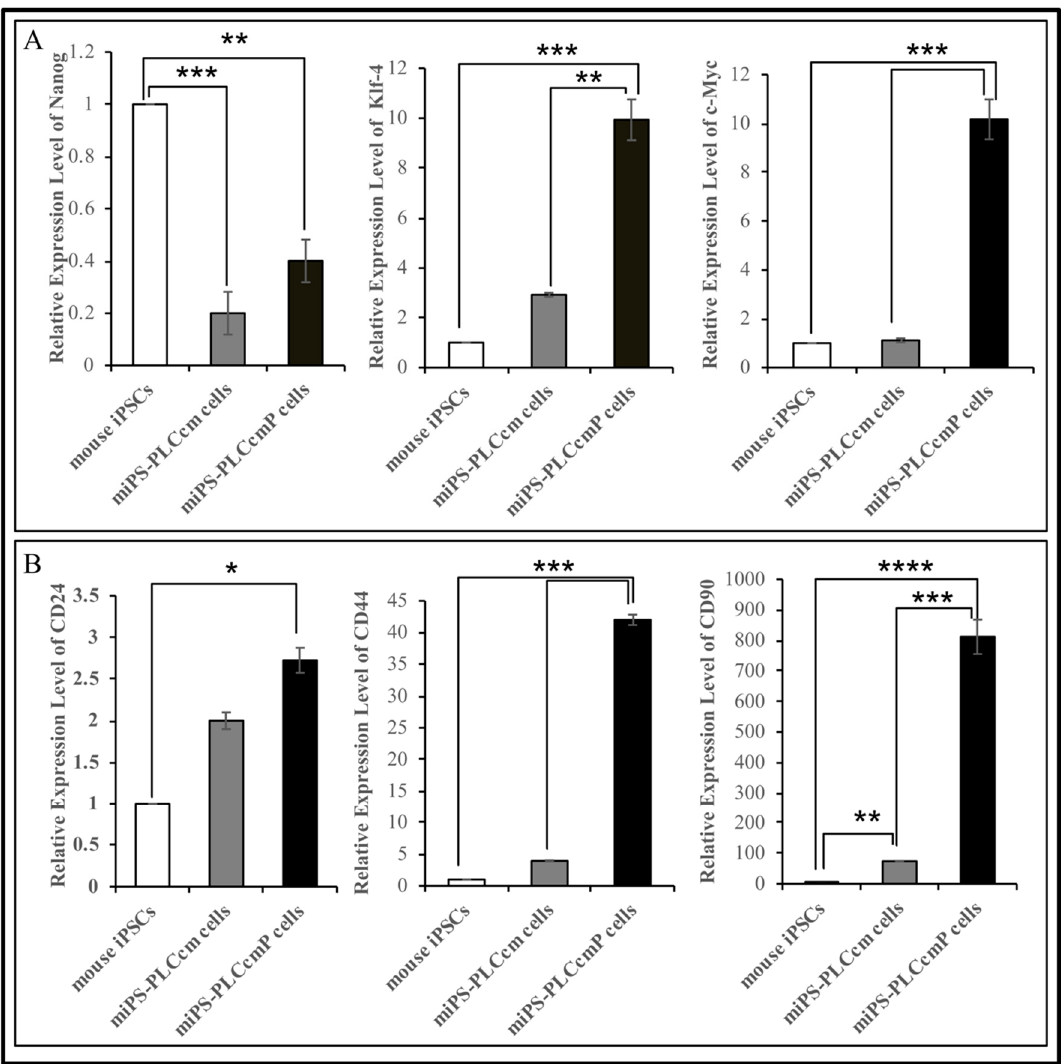
Figure 6. Characterization of cancer stem cells derived from iPSCs in the presence of conditioned medium derived from PLC cells and the primary culture derived from developed the malignant tumor. ( A ) RT-qPCR analysis of stemness markers in miPS-PLCcm and miPS-PLCcm P cells and in comparison, with miPSCs.; ( B ) RT-qPCR analysis of CSC markers in miPS-PLCcm and miPS-PLCcm P cells in compassion with mouse iPSCs.